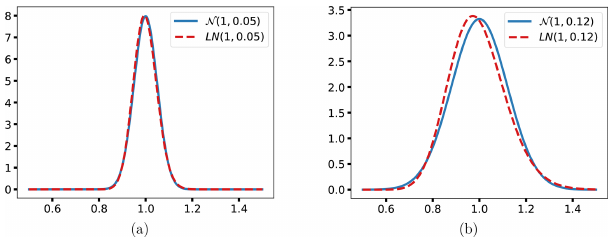
Figure 6. Normal distribution vs. log-normal distribution shar- ing mean and standard deviation: mean 1.0 and standard deviation 0.05 (a) ; mean 1.0 and standard deviation 0.12 (b)